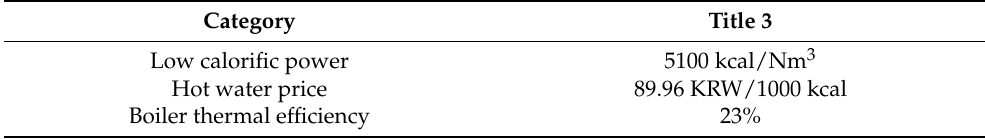
Table 2. Biogas thermal efficiency and hot water price.